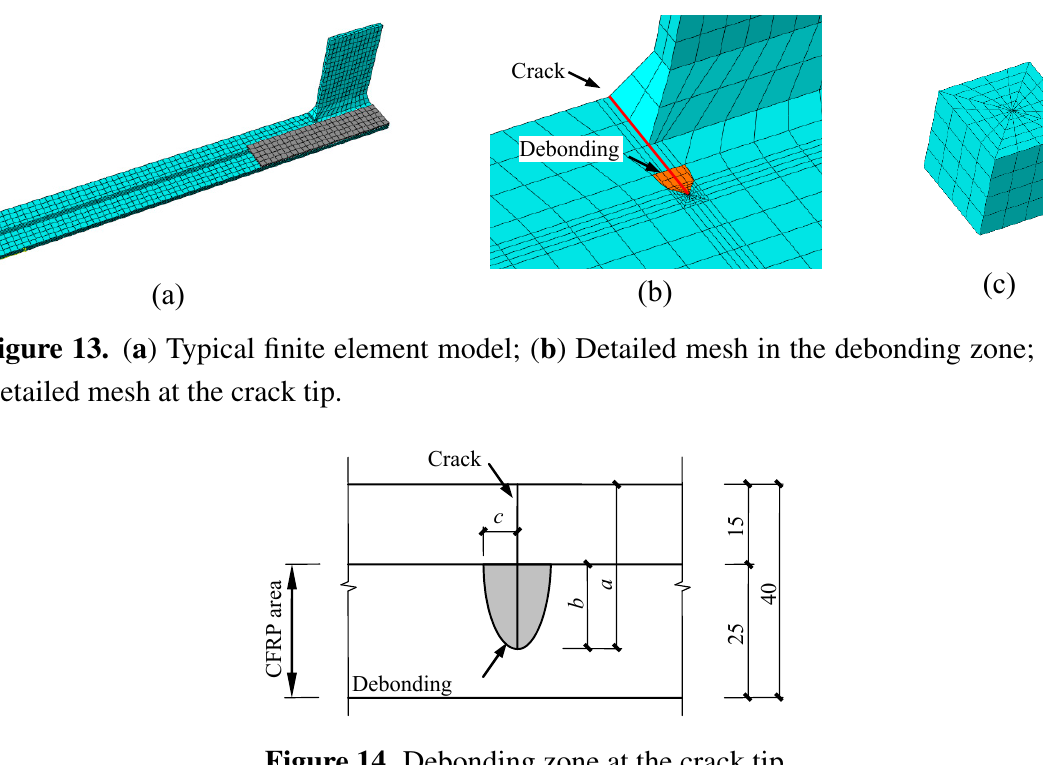
Figure 14. Debonding zone at the crack tip.